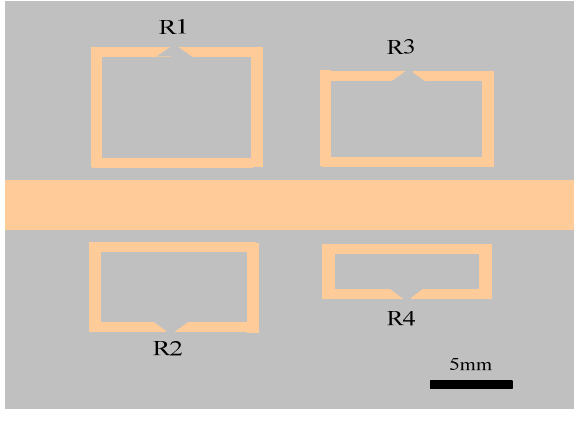
Figure 8. Diagram of four-channel sensor containing four SRR’s